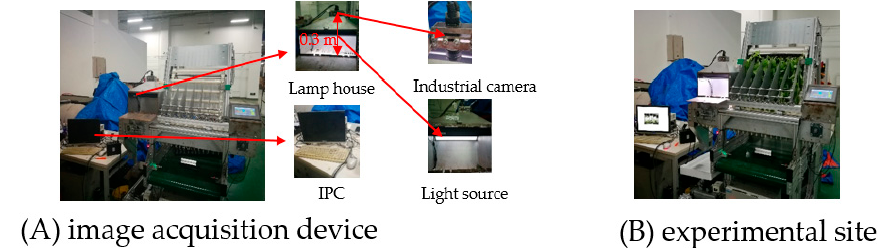
Figure 1. Image acquisition. ( A ) Image acquisition device; ( B ) experimental site.